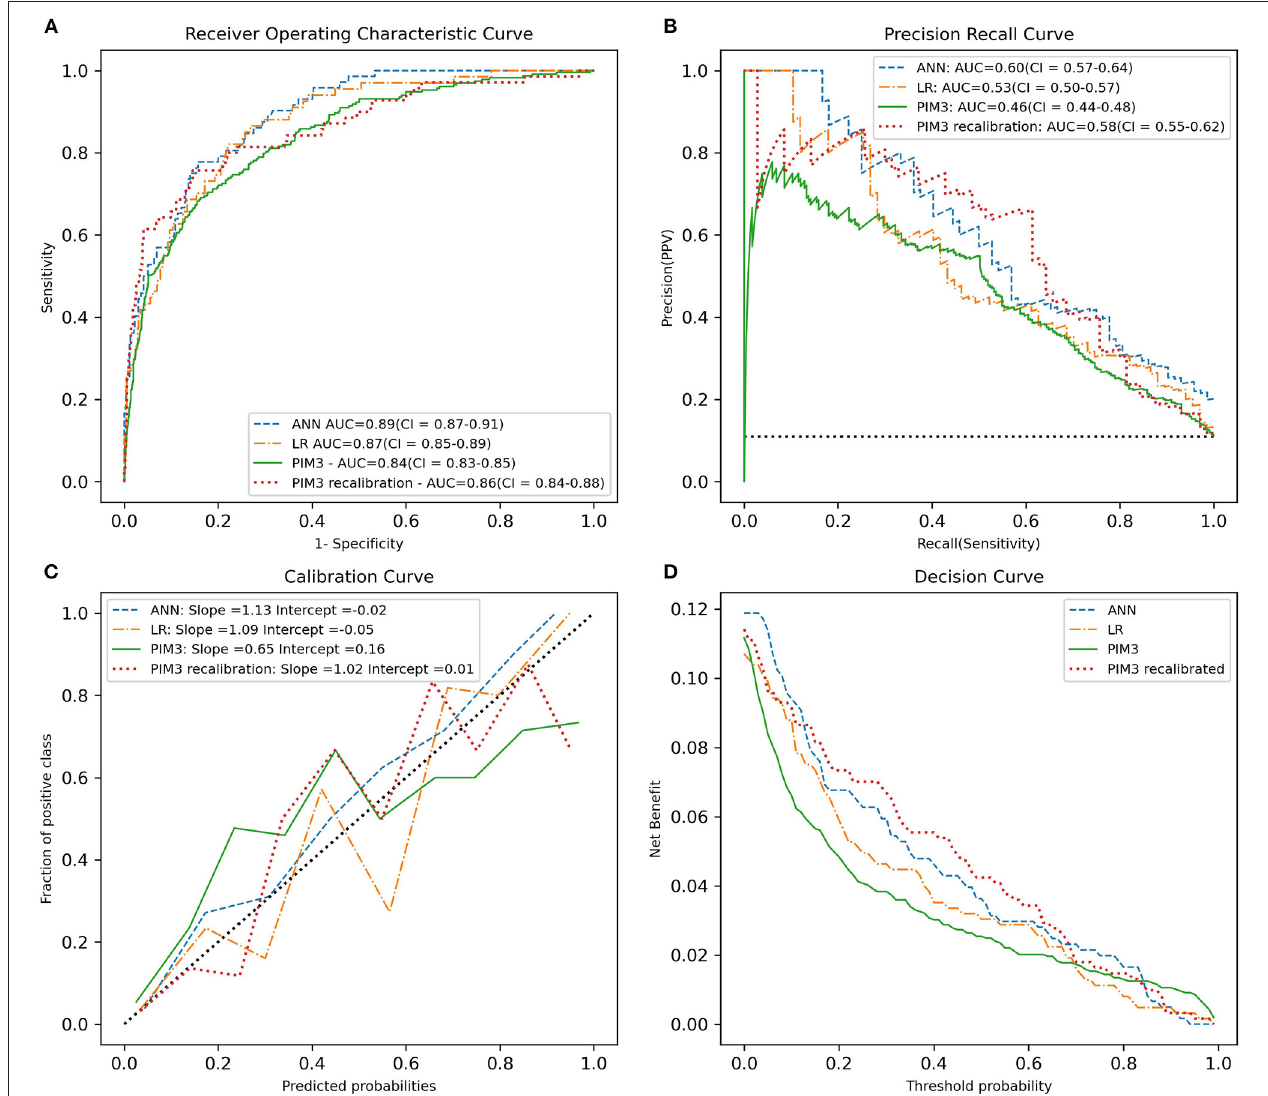
FIGURE 1 | Predictive performance of the ANN, LR, recalibrated PIM3 and original PIM3 models. (A) The ROC curve. (B) The precision-recall curve. (C) The calibration cure. (D) The decision curve. The area under the curve in A and B and the slope of the calibration curve in C are shown in the legend. PIM3 performance metrics were calculated across the whole data set, while the ANN and LR performance metrics were calculated on the test